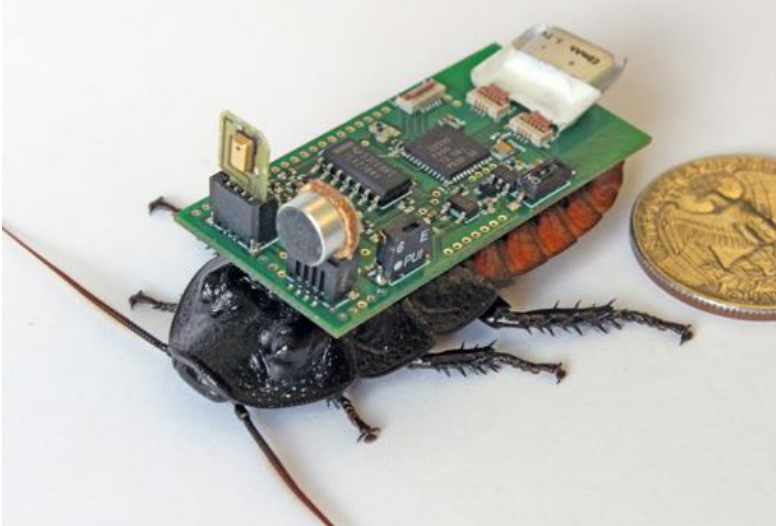
Figure 18. A Madagascar hissing cockroach with specially designed CC2530-based miniature backpack for acoustic ranging and localization